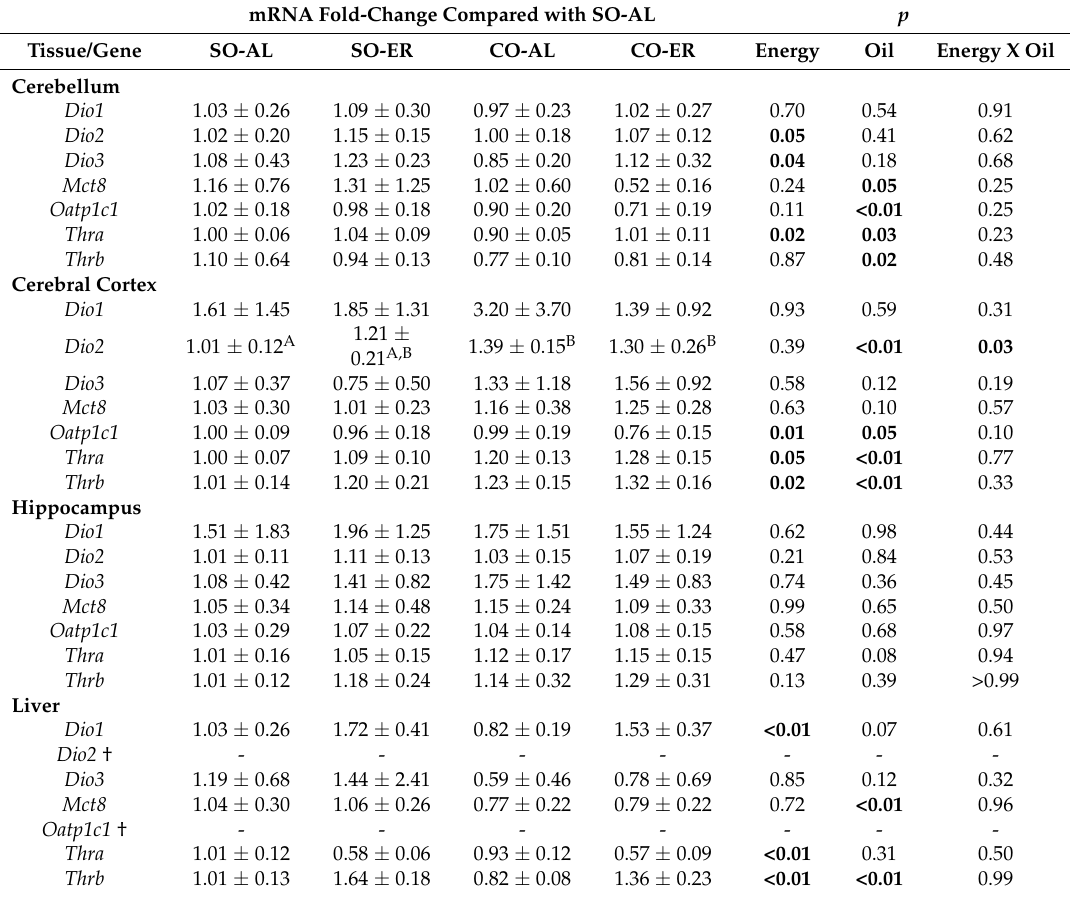
Table 9. Tissue mRNA expression of thyroid hormone (TH) mediators. mRNA Fold-Change Compared with SO-AL p Tissue/Gene SO-AL SO-ER CO-AL CO-ER Energy